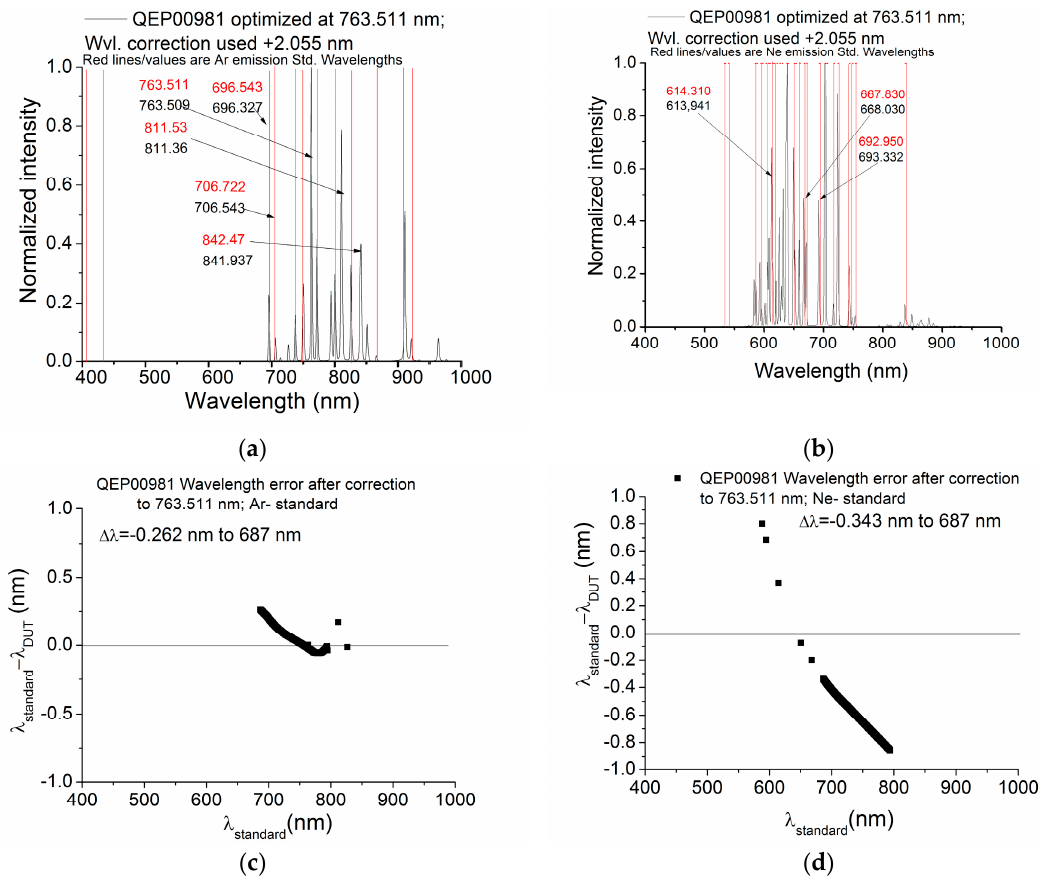
Figure 10. The wavelength corrections for ( a ) Ar and ( b ) Ne lamps’ emission lines measured with the QEP00981 ( λ DUT ; DUT, device under test) after optimization at 763.511 nm and the corresponding errors ( c , d ) related to the standard values ( λ standard ). The red lines represent the standard emission lines for Ar and Ne lamps.